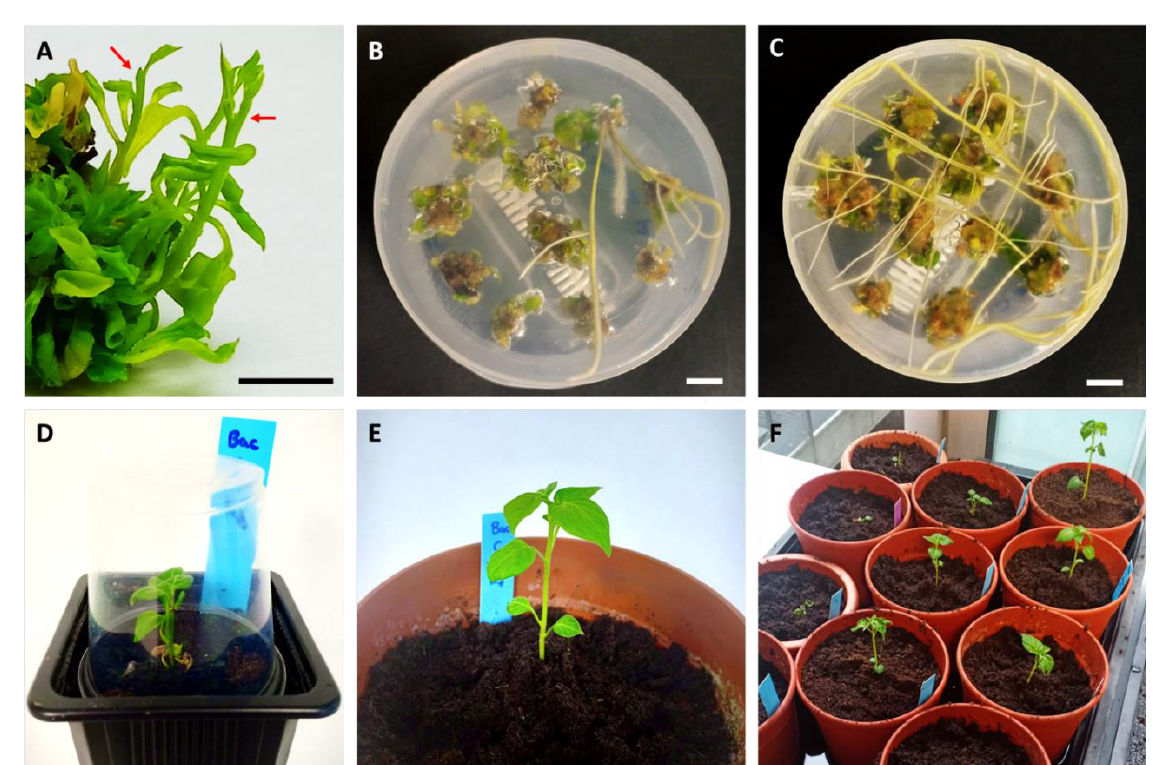
Figure 5. Elongation, rooting and acclimatization process of Capsicum spp. plants from the Pep1.1 + Pep1.2 organogenesis medium. Detail of the elongated shoots in a C. baccatum cotyledon explant, with clear apical meristems (arrows) at the top of the shoots ( A ). Images of isolated shoots of cotyledon explants of C. baccatum grown in R1 ( B ) and R2 ( C ) media. Acclimatization and rooting process of C. baccatum plants once they have been rooted in vitro, including the covering during the first stages with a plastic glass ( D ), which is gradually opened and removed ( E ) until the plantlets can develop without needing protection ( F ). The bar for reference measures 1 cm. Table 9. Rooting of shoots of C. annuum , C. baccatum and C. chinense in R1 medium (0.5 mg/L of IBA) and in R2 medium (1 mg/L of IBA). The data represent the number of cotyledon and hypocotyl explants transferred and percentage of rooted explants ± standard error.